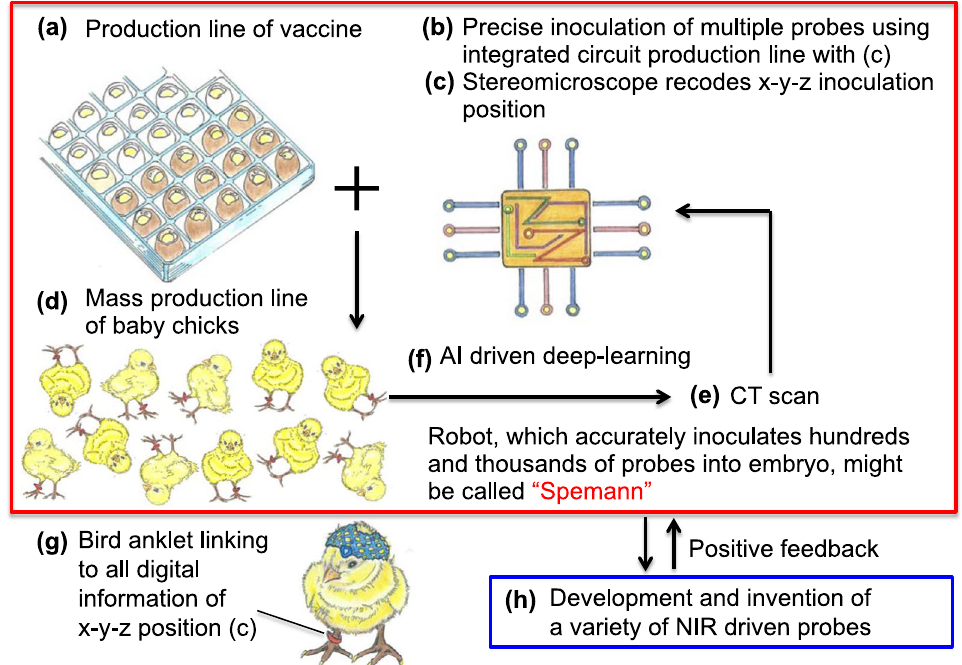
Fig. 3 The necessity to develop the robot “Spemann”. We propose how to automatically inoculate probes into chick brains. To achieve accurately embedding the beads in specific regions of the brain, it is essential to develop automatic robotic inoculation systems (Fig. 2b). The following four different industrial systems ( a – d ) exist: ( a ) the traditional pharmaceutical vaccine production line (which automatically sterilizes fertilized chick eggs and bores a hole in the eggshell), an automatic precise probe inoculation system combining ( b ) an integrated-circuit electronic production line and ( c ) an automatic staging and recording stereomicroscope system (utilized in various biological and medical sciences to record digital information of the x_y_z position of the object), and ( d ) poultry farming for the massive production of chicks. Combining these industries will enable a mass production line of chicks whose brains contain hundreds of beads (probes) (Fig. 2b). Moreover, ( e ) computed tomography scanning of chick brains could individually, precisely, and digitally record the x_y_z position of each embedded bead in the brain. Finally, ( f ) artificial intelligence-mediated